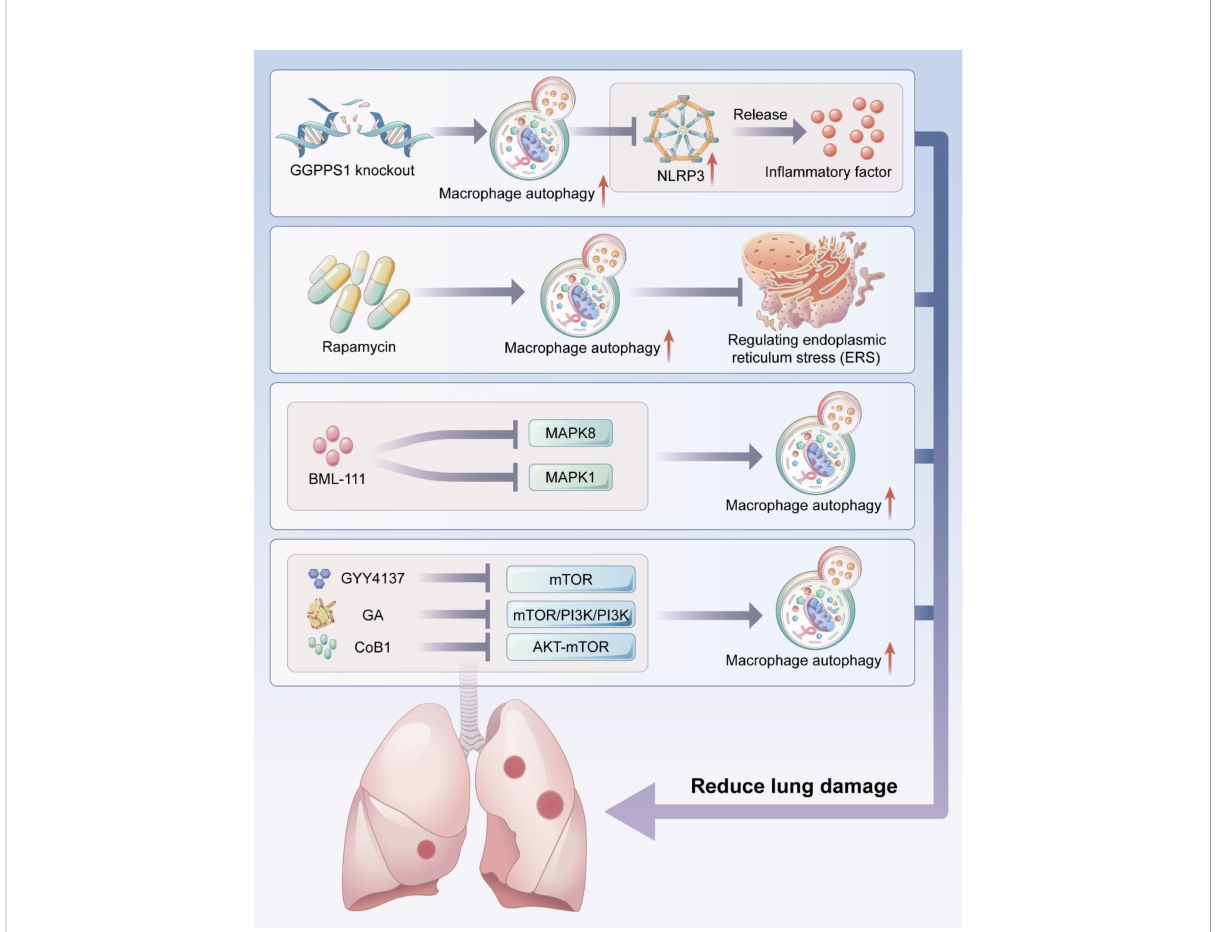
FIGURE 3 Macrophage autophagy reduces lung injury. Macrophage autophagy can reduce acute lung injury by inhibiting NLRP3 activity and endoplamic reticulum stress (ERS), and several studies have demonstrated that activating macrophage autophagy by targeting MAPK signaling pathway and mTOR signaling pathway can reduce lung